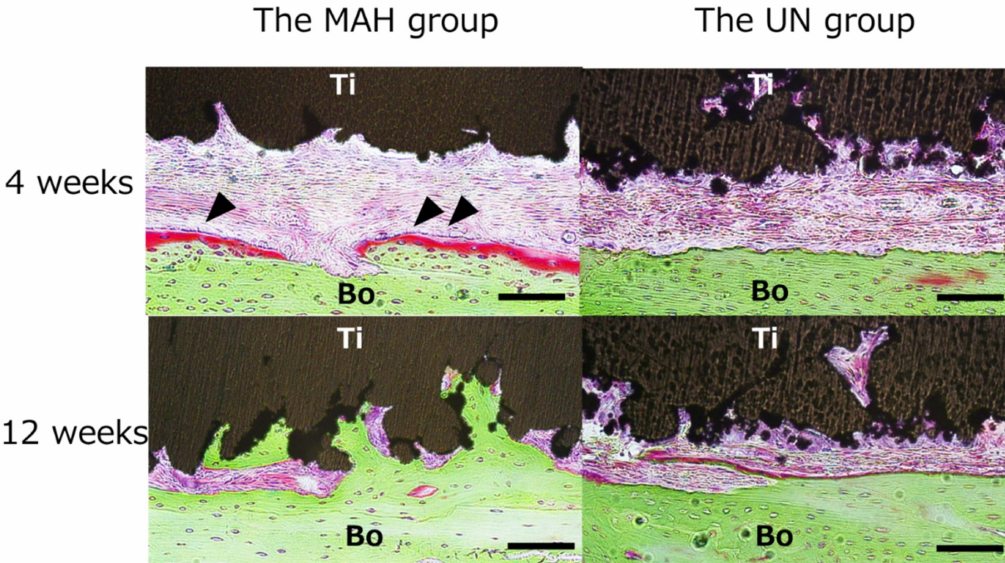
Figure 8. Enlarged histological observation. The MAH group at 12 weeks, showing active bone formation fromtheTisurfacetowardthedeeppart. Thescalebarindicates100 µ m. Ti: Titaniumplate,Bo: